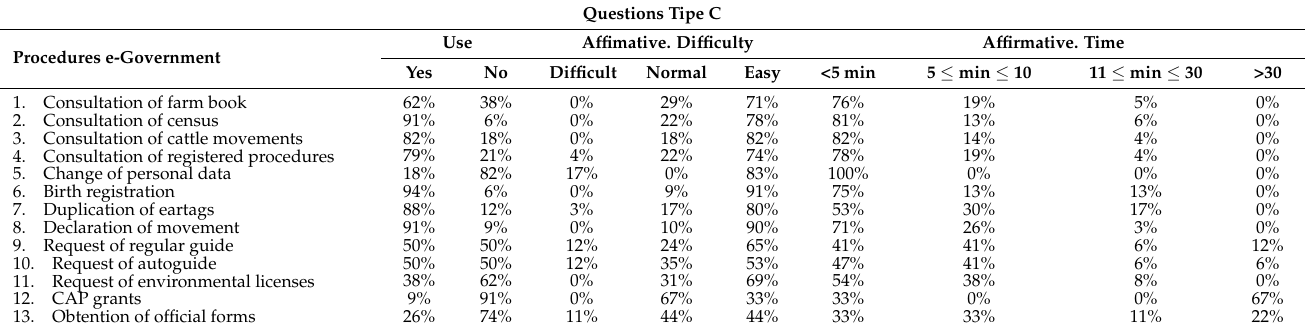
Table 1. Type C Questions. Percentage of